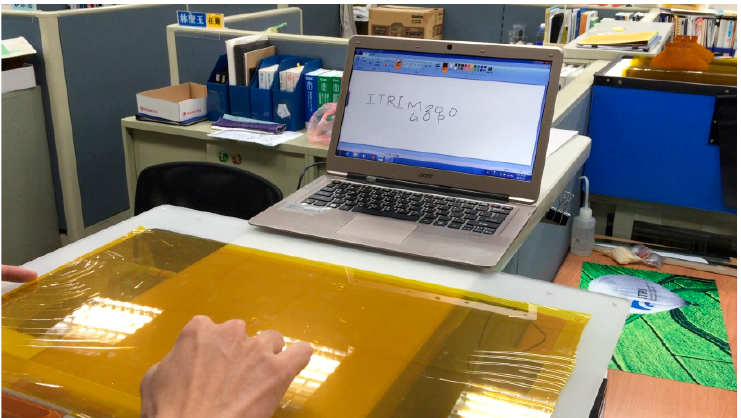
Figure 10. Demonstration of 23 in. metal-mesh touch sensor.